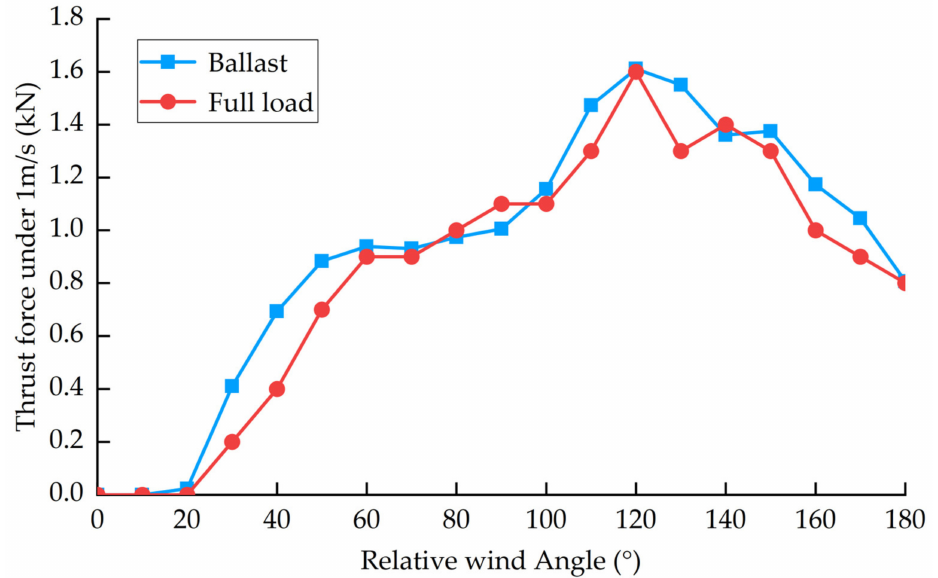
Figure 11. Thrust force of wing sail at different relative wind